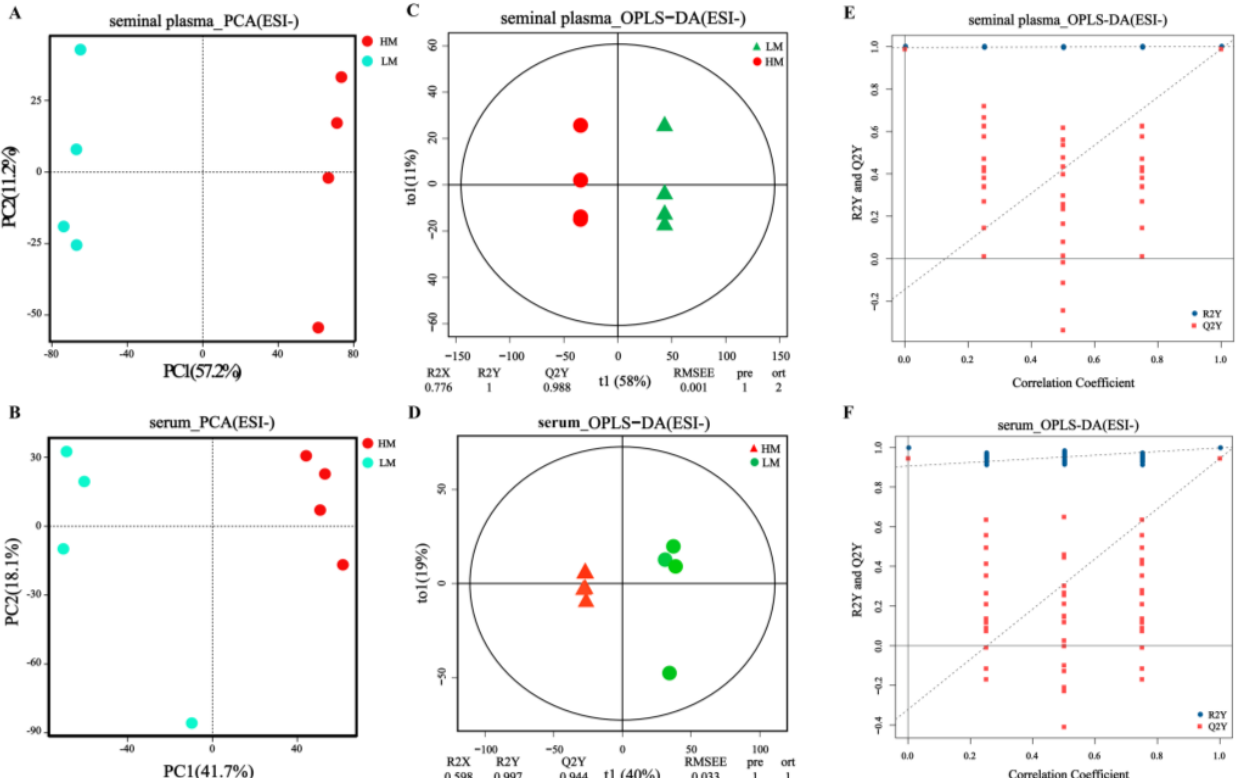
Figure 5. Rumen microbial composition and diversity between LM and HM groups of sheep. ( A ) Taxonomic composition of rumen microorganisms at the phylum level between the two groups. ( B ) Significantly differentiated microbes at the phylum level ( p < 0.05, determined by Wilcoxon rank- sum test). ( C ) Taxonomic composition of rumen microorganisms at the genus level between the two groups (1%, according to relative abundance). ( D ) LEfSe analysis at the genus level (LDA > 2). ( E ) PCoA analyses based on Bray − Curtis distance. ( F ) Analysis of the ruminal microbiota using PLS − DA. LM, low − motility group; HM, high − motility group.